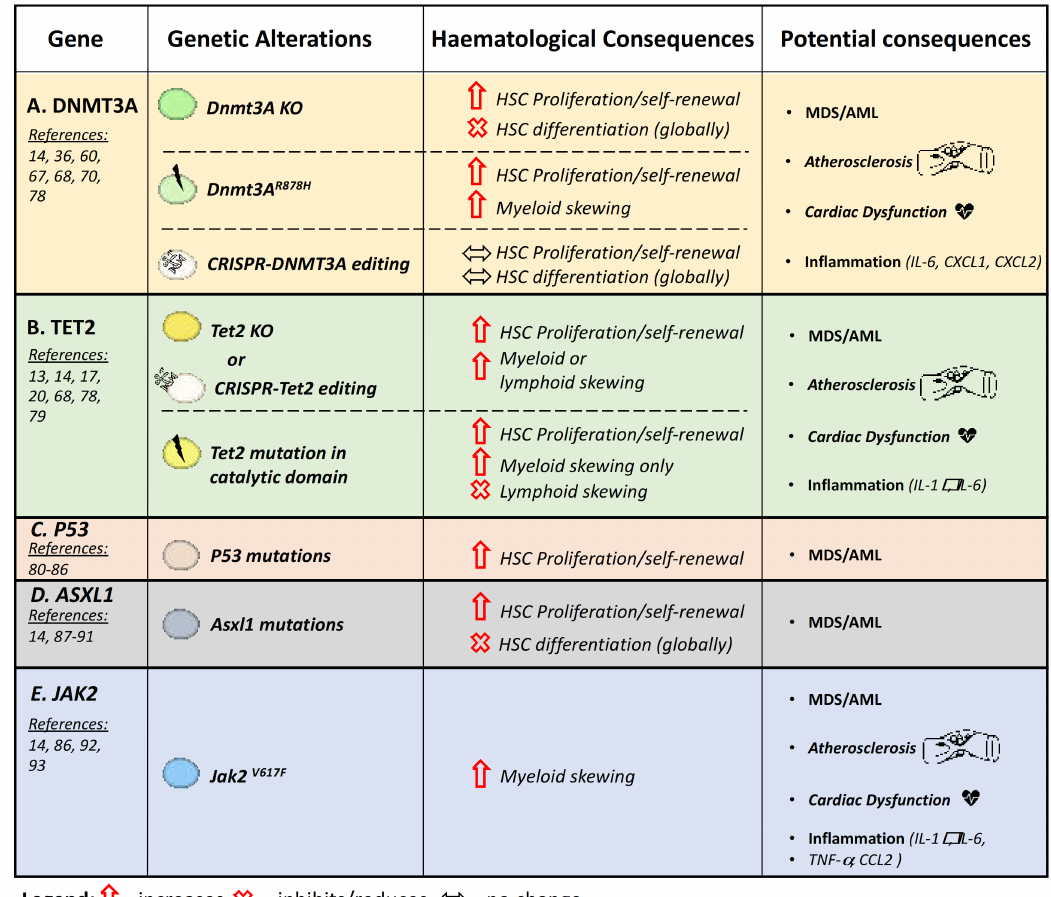
Figure 2. Hematopoietic and disease consequences of the top 5 genes mutated in CHIP. ( A ) DNMT3A: KO, single spot loss- of-function mutation and CRISPR editing studies [14,36,60,67,68,70,78]. ( B ) TET2: KO, CRISPR editing or mutation in the catalytic domain only studies [13,14,17,20,68,78,79]. ( C ) P53: studies utilizing P53 loss-of-function mutations [80–86]. ( D ) ASXL1: studies reporting the